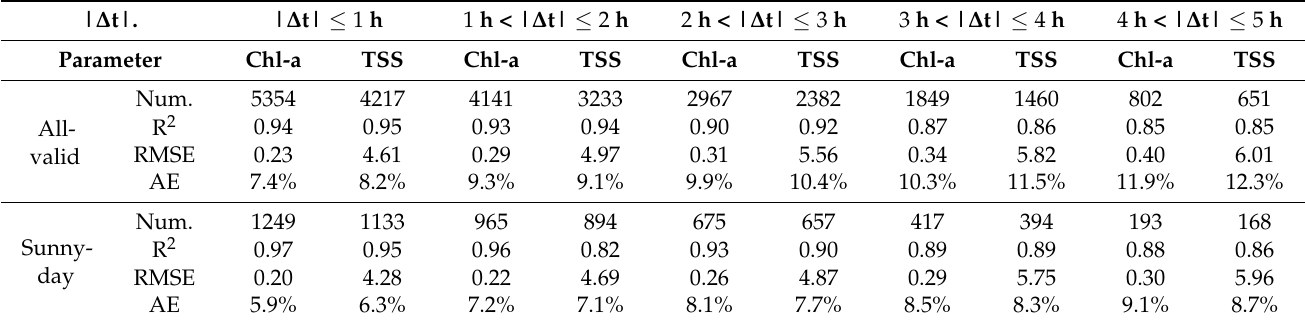
Table 7. The testing accuracy of GRNN-based model built according to different | ∆ t | in the all-valid and the sunny-day datasets